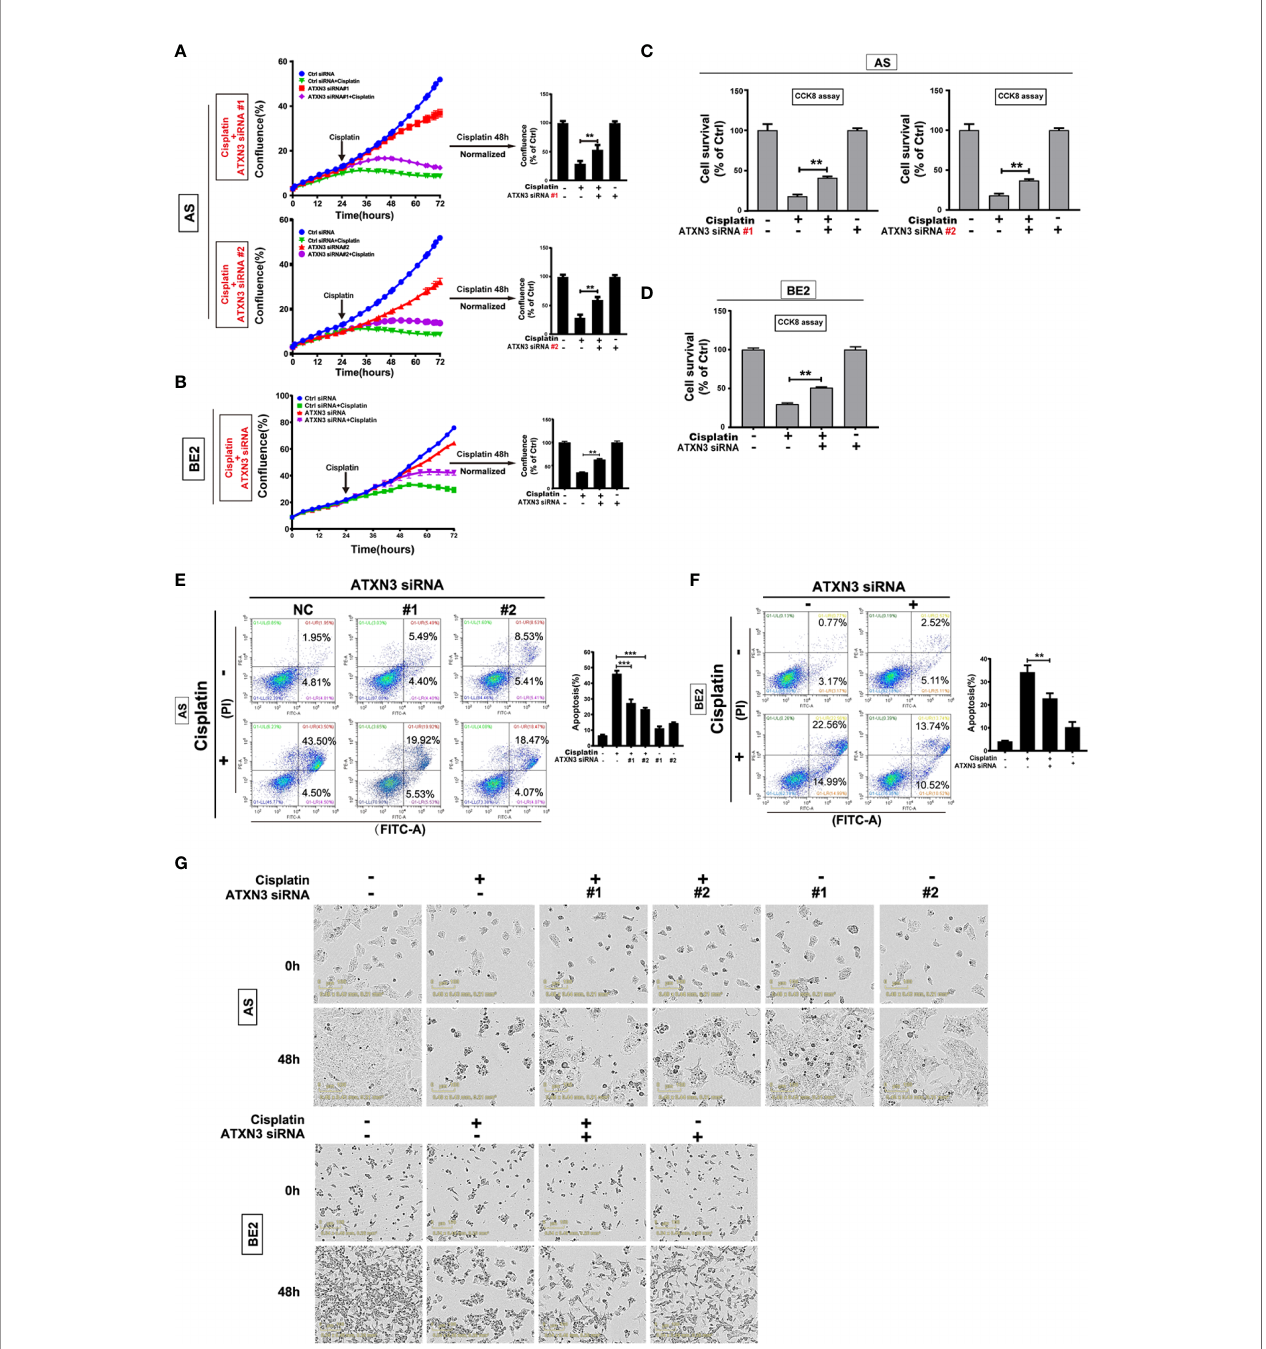
FIGURE 5 | Downregulation of ATXN3 decreased the sensitivity of NB cells to cisplatin. AS cells were transfected with ATXN3 siRNAs (#1, #2) and BE2 cells were transfected with ATXN3 siRNA #2 (marked as ATXN3 siRNA) for 16 h, followed by 48 h treatment of cisplatin. (A, B) Cell con fl uence was dynamically detected and analyzed by IncuCyte Zoom; (C, D) Cell survival was detected by CCK8 assay; (E, F) Cell apoptosis was detected by Annexin V/PI fl ow cytometry; (G) The images of AS and BE2 cells with ATXN3 siRNAs transfection and cisplatin treatment at 0 h and 48 h were recorded. Bar, SD, ***, P<0.01, **, P<0.01, ATXN3 siRNAs +cisplatin vs. control siRNA +